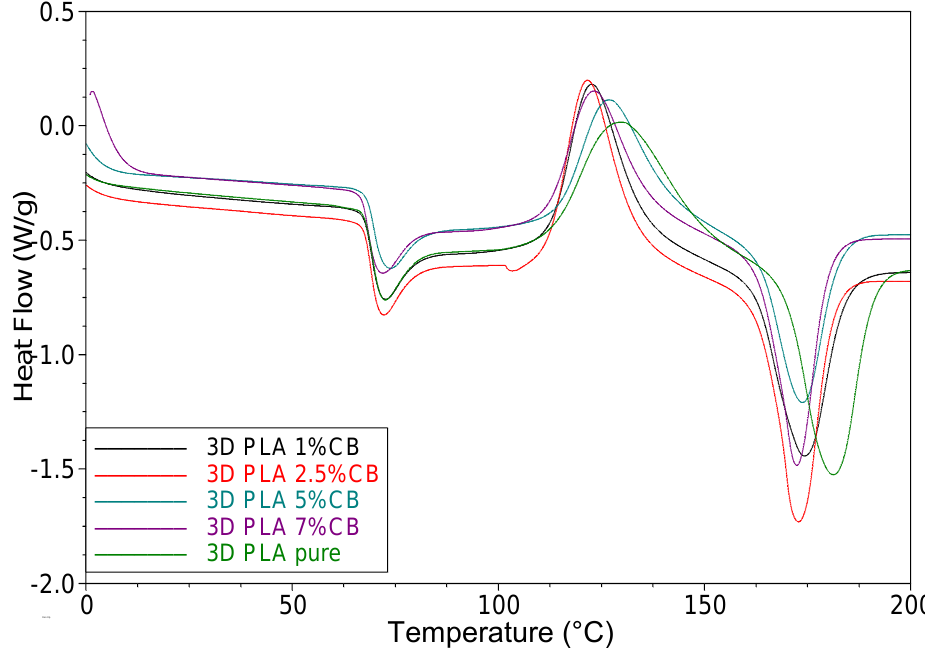
Figure 10. DSC curves ( Ⅰ run) of the 3D-printed specimens, obtained from the composite filaments with various CB content.